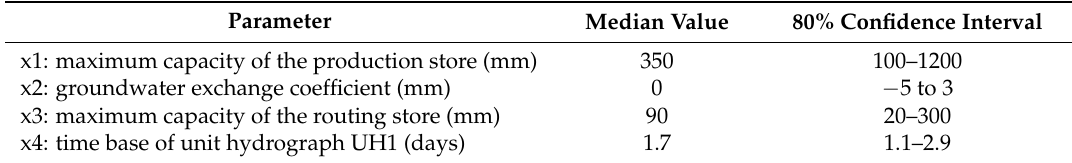
Table 2. Median values and approximate 80% confidence intervals of four model